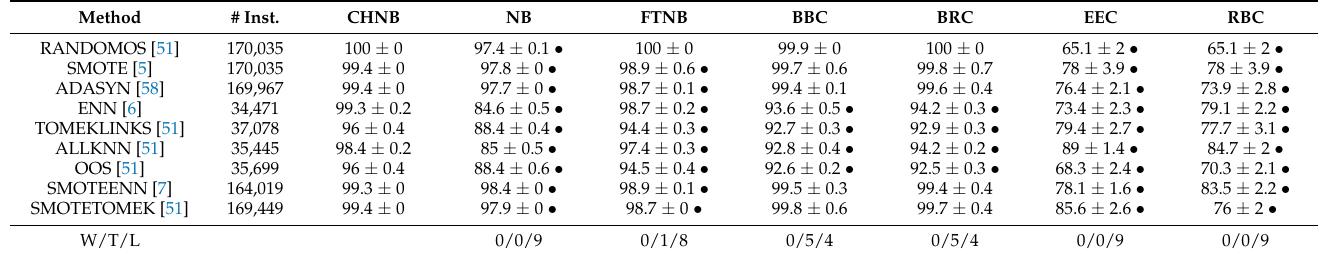
Table 7. Macro F-score for the classifiers combined with different resampling methods on the WSN dataset.